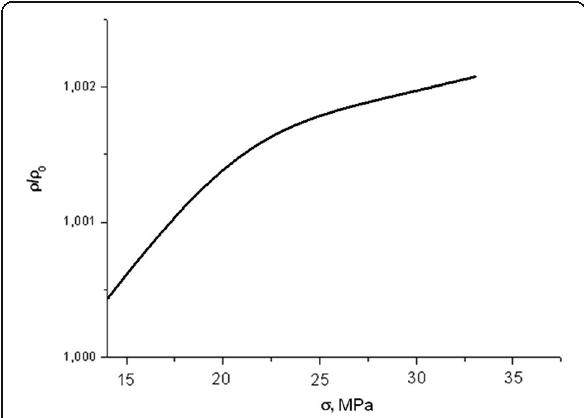
Fig. 2 Dependence of longitudinal resistance of primary dislocation-free sample during the elastic deformation with the deformation rate 8 μ